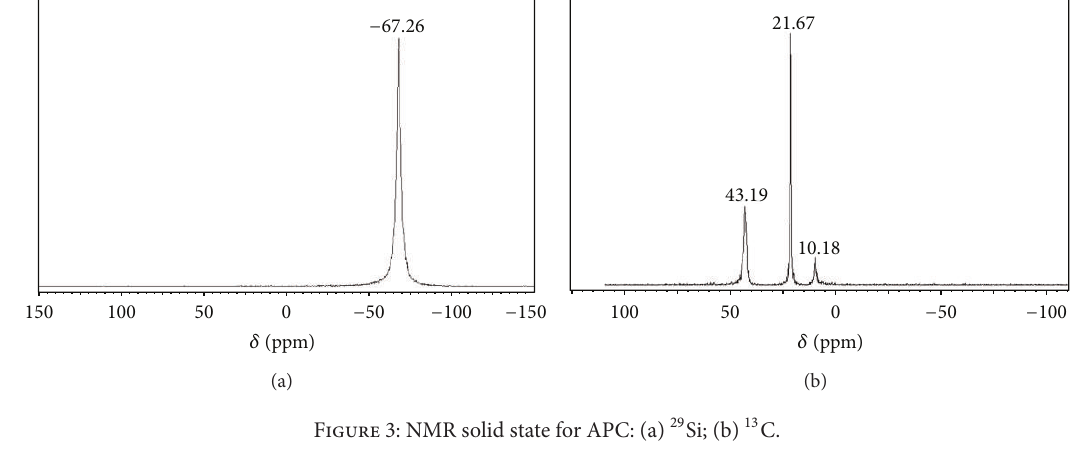
Figure 3: NMR solid state for APC: (a) 29 Si; (b) 13 C.